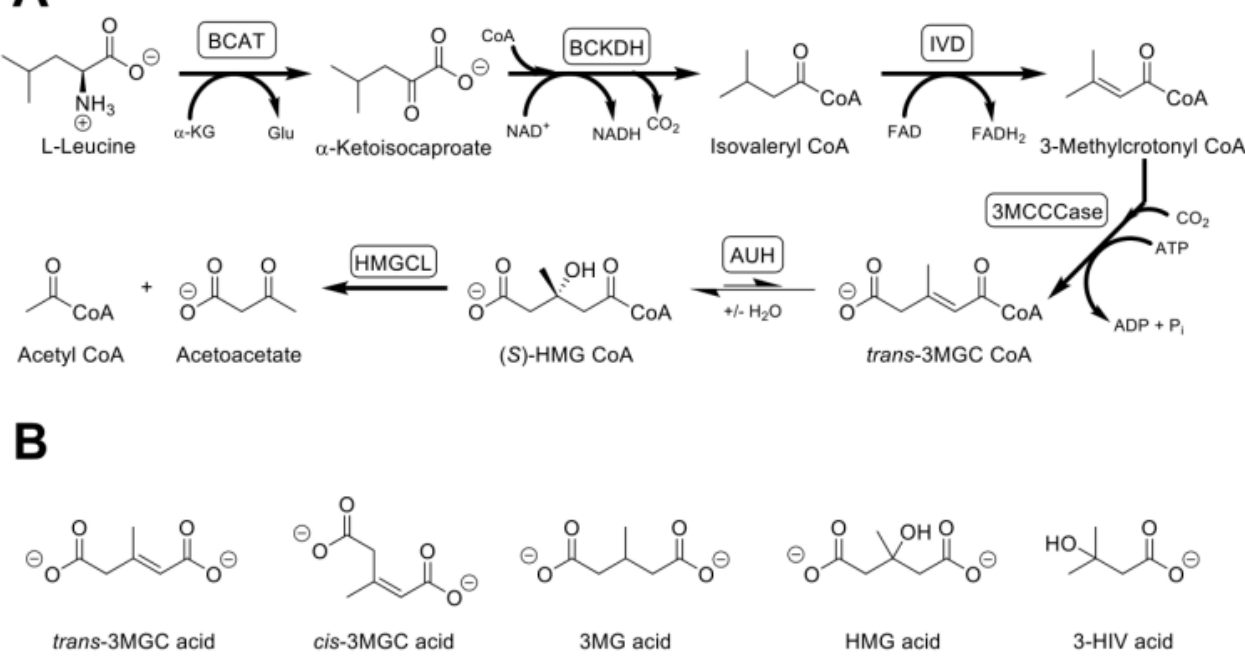
Figure 1. The leucine catabolism pathway. (Panel ( A )) L-leucine is initially converted to α - ketoisocaproate in a reaction catalyzed by branched chain aminotransferase (BCAT) which employs α -ketoglutarate ( α -KG) as amino group acceptor, yielding glutamate (Glu). α -Ketoisocaproate is then oxidatively decarboxylated by branched chain α -keto acid dehydrogenase (BCKDH) to form isovaleryl CoA. Subsequently, isovaleryl CoA dehydrogenase (IVD) oxidizes isovaleryl CoA to 3- methylcrotonyl CoA. This metabolite is then carboxylated to trans -3MGC CoA by 3-methylcrotonyl CoA carboxylase (3MCCCase). trans -3MGC CoA is then dehydrated by AUH to form ( S )-HMG CoA which is cleaved by HMG CoA lyase (HMGCL), forming acetoacetate and acetyl CoA. (Panel ( B )) Inborn errors of metabolism that lead to a deficiency in either AUH or HMGCL prevent complete catabolism of L-leucine, resulting in the excretion of organic acids, including trans -3MGC acid, cis -3MGC acid, 3-methylglutaric (3MG) acid, HMG acid (only in HMGCL deficiency) and 3-hydroxyisovaleric (3-HIV)